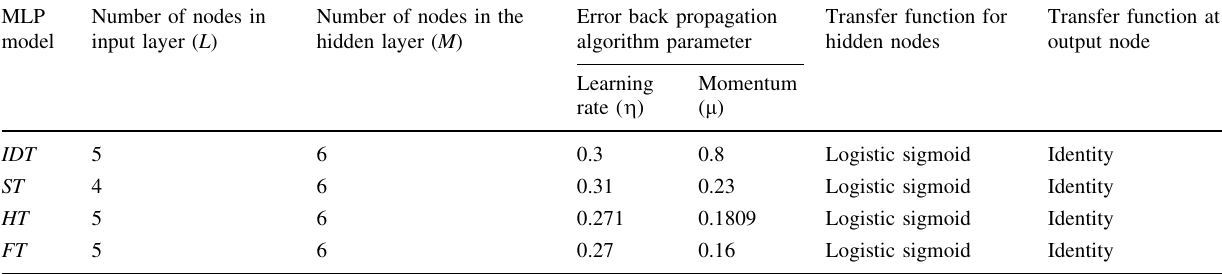
Table 4 Details of the MLP-based optimal models for the prediction of IDT , ST , HT, and FT MLP model